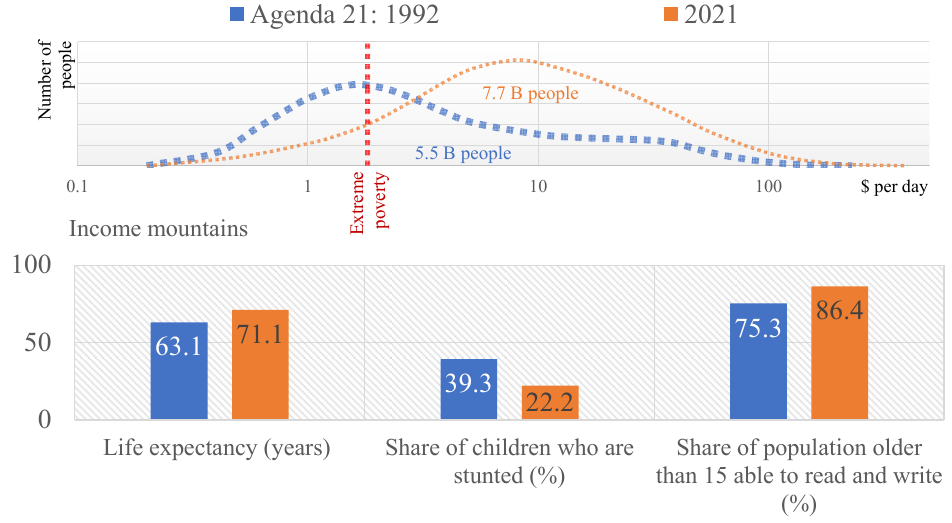
Figure 12. Global data from 1992 (Agenda 21) and 2021. Top: Income mountains [173]; Bottom: Life expectancy (years), share of children who are stunted (%), share of population older than 15 able to read and write (%).